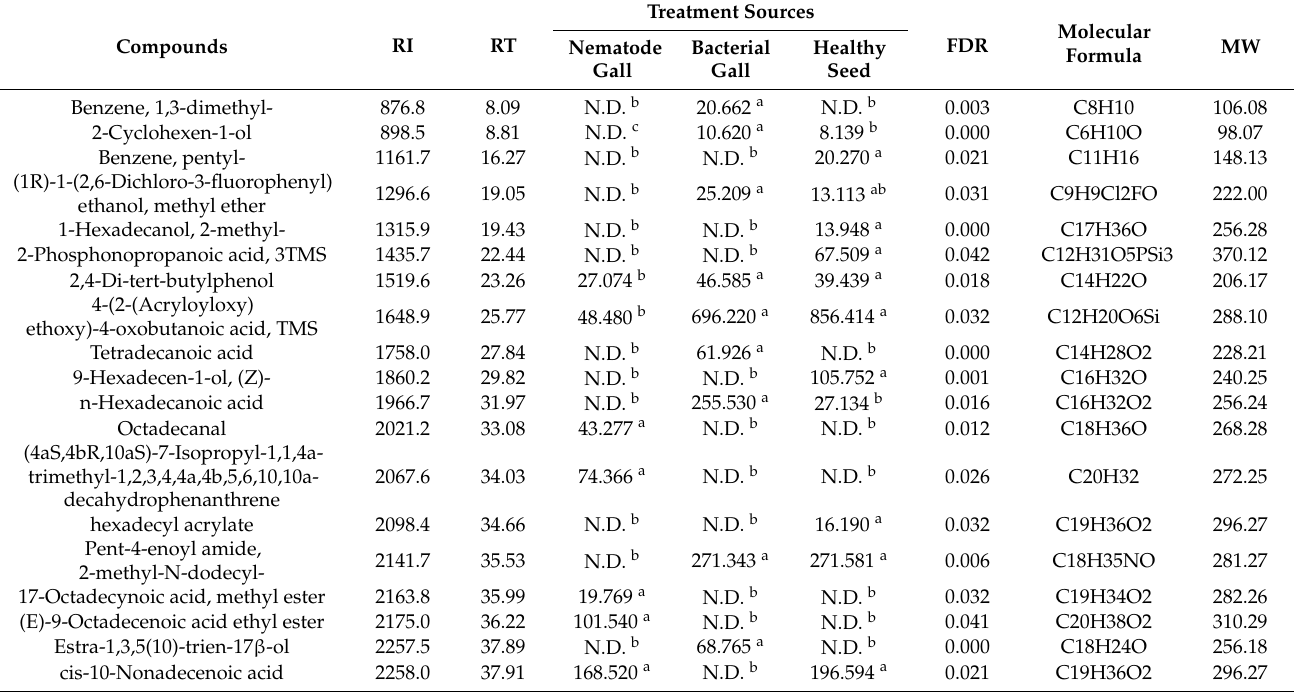
Table 1. Significant compounds’ peak areas (one unit corresponds to 10 4 area) quantified in nematode galls, bacterial galls and healthy seeds of annual ryegrass seed using DI-SPME